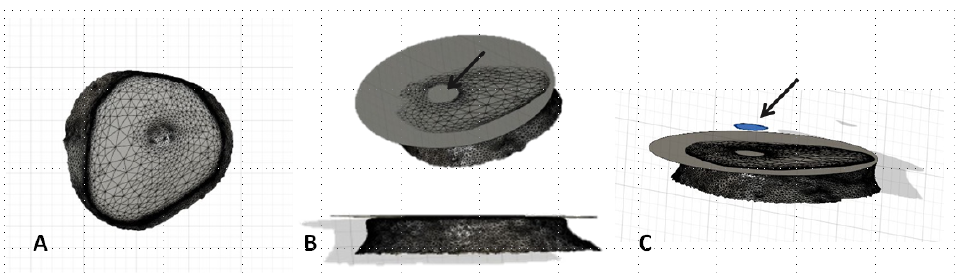
Figure 4. Resin teeth specimens were subjected to a surface scan using a three dimensional (3D) scanner for wear measurement. ( A ) A Standard Triangulated Language (STL) file of a resin tooth specimen after the wear test. ( B ) A new plane was defined by three points on a flat unworn surface. ( C ) The volume of space between the new plane and the worn surface was calculated. Arrow indicates the volume of loss.